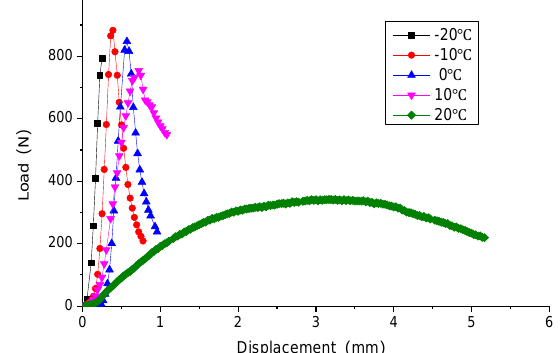
Figure 2. Load-displacement diagram of AC-16 at different temperatures.